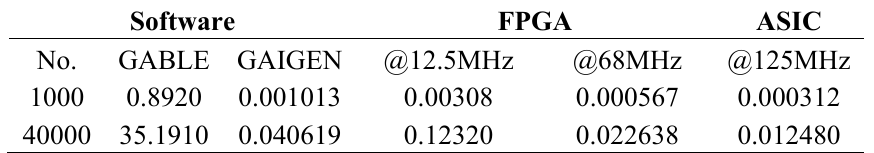
Table 4. Comparison of Software and the hardware for vector and bivector